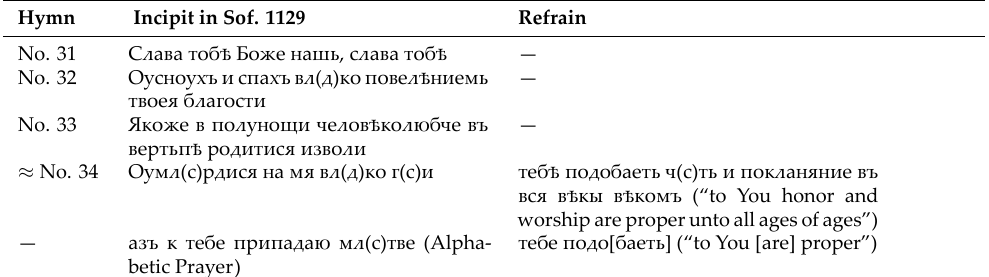
Table 5. The kata stichon hymns of the Midnight Office in St. Petersburg, RNB MS Sof.